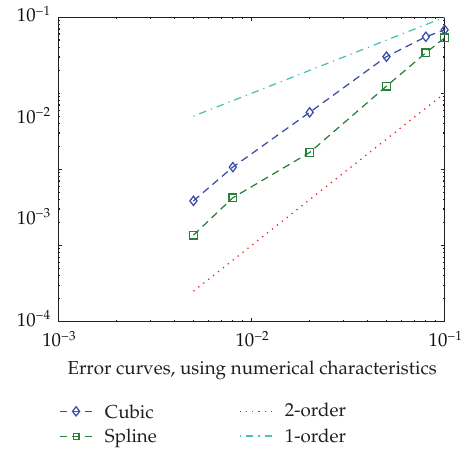
Figure 3: 𝐸 𝑙 2 -errors of BDF2 using CI and CSI with 𝜈 = 1.25×10 −4 ; 𝑇 = 𝜋/4 , ℎ = Δ𝑡 = 0.1, 0.08, 0.05, 0.02, 0.008, 0.005